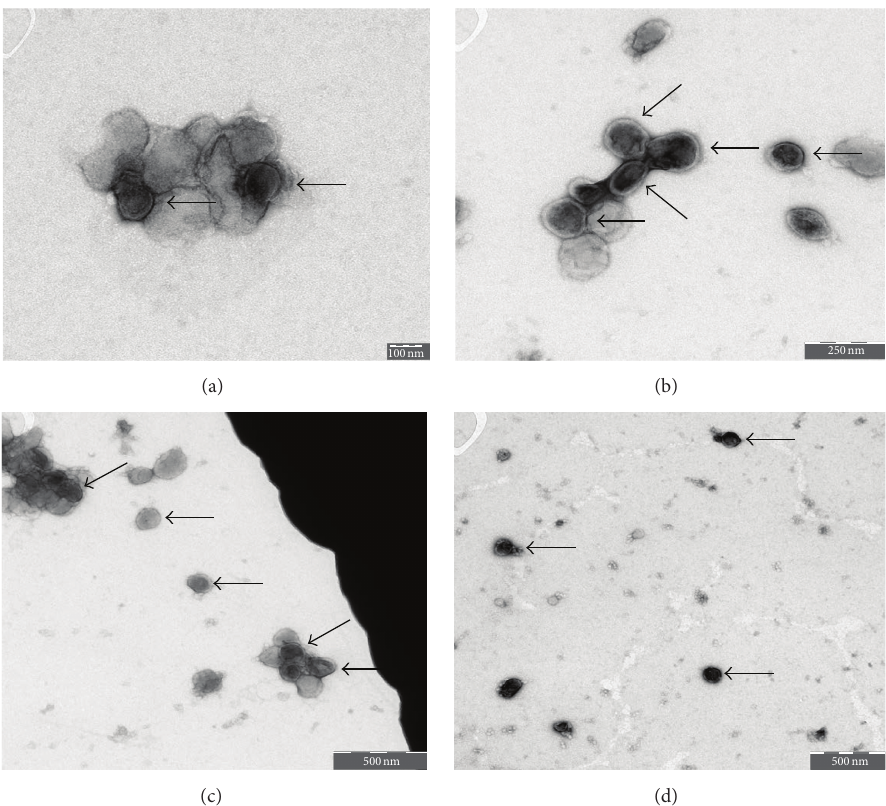
Figure 2: Visualization of purified synovial sarcoma microvesicles (arrows) by transmission electron microscopy (TEM). (a) Bar indicating 100nm. (b) Bar indicating 250 nm. ((c) and (d)) Bar indicating 500 nm.